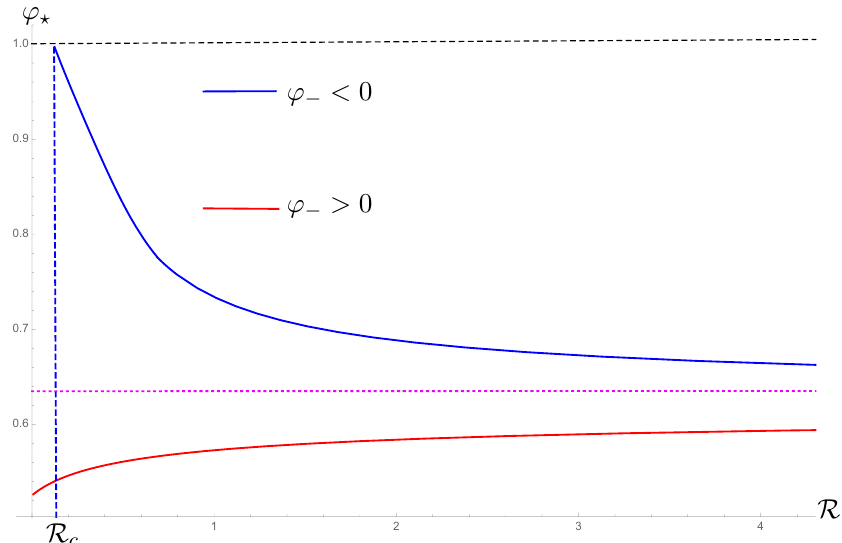
Figure 6 . Equilibrium brane position ’ ? vs. R for bulk potential (3.1), brane quantities (3.2) and parameter values (3.3). The blue line corresponds to solutions with ’ (cid:0) < 0 while the red line denotes solutions with ’ (cid:0) > 0. The brane position cannot exceed the position of the minimum of the potential at ’ min = 1, which is indicated by the black dashed line. For R ! 1 both the red and blue branch asymptote to the value for ’ ? indicated by the dotted magenta